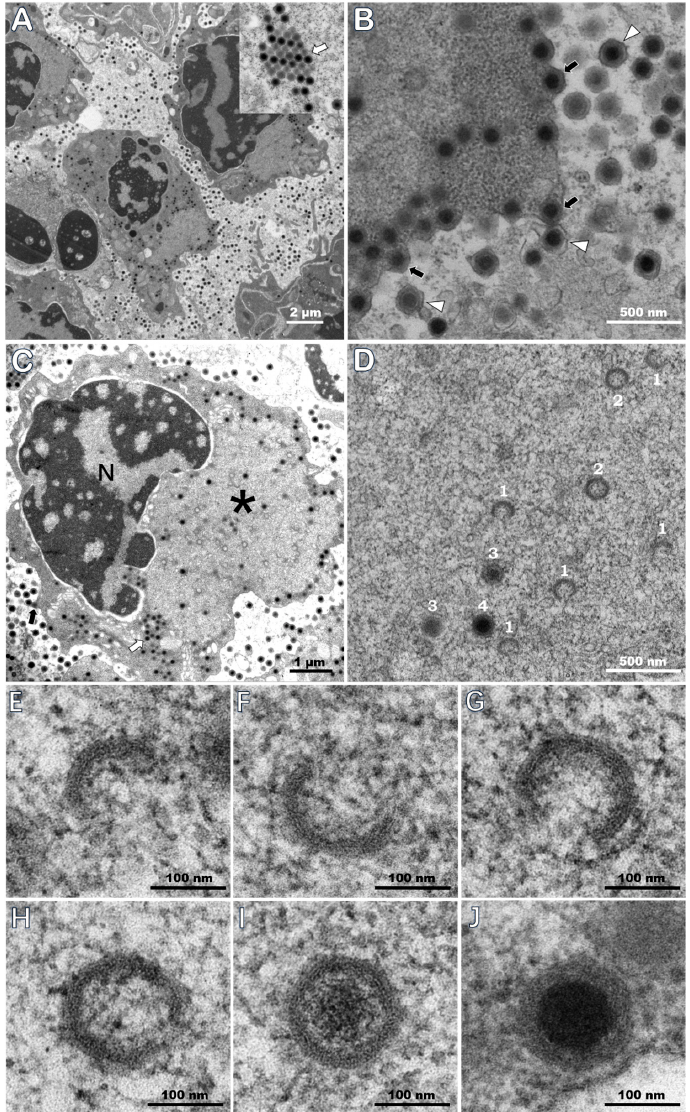
Figure 4. TEM of hematopoietic tissue of naturally infected M. rosenbergii samples 20180620. ( A ) A large numbers of virions in hematopoietic tissue. ( B ) DIV1 budded and acquired an envelope from the plasma membrane. ( C ) DIV1 replication and assembly in hematopoietic cells. ( D ) The stages of nucleocapsid assembly, which are indicated with numbers 1–3, and a complete nucleocapsid is indicated with number 4. The capsids at stage 2 and 3 should have a small opening at one vertex but may not be visible in the picture due to the ultrathin section. ( E ) Crescent-shaped structures. ( F – I ) As the assembling process continues, the crescent-shaped structure curves to form icosahedral capsids. ( J ) A mature virion with a dense core was eventually formed. N: nucleus; *: a large electron-lucent virogenic stroma; white arrows: paracrystalline array of viral particles; black arrows: budding virions; and white triangles: budded virions that acquired an